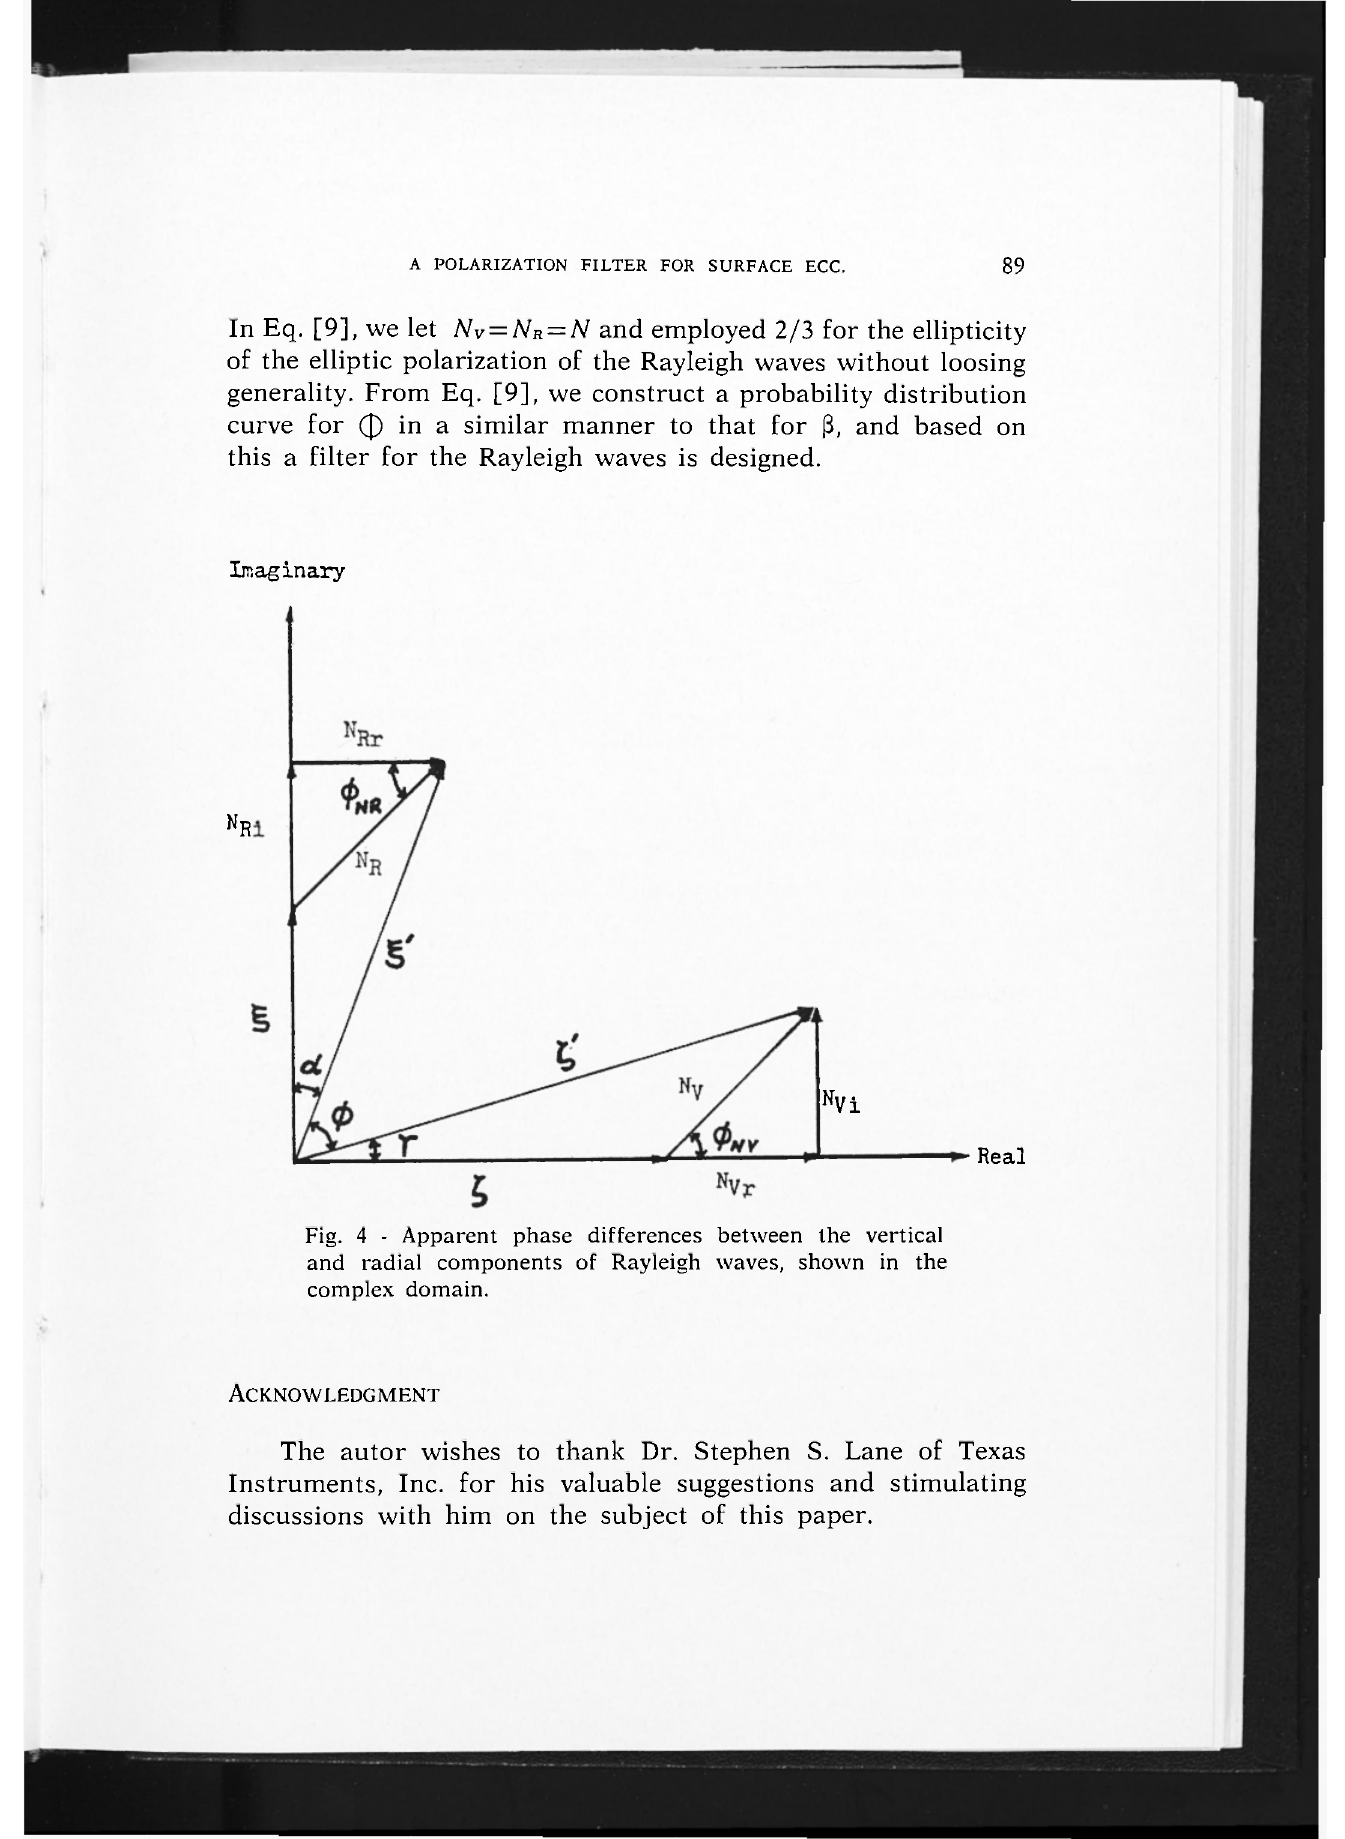
Fig. 4 - Apparent phase differences between the vertical and radial components of Rayleigh waves, shown in the complex